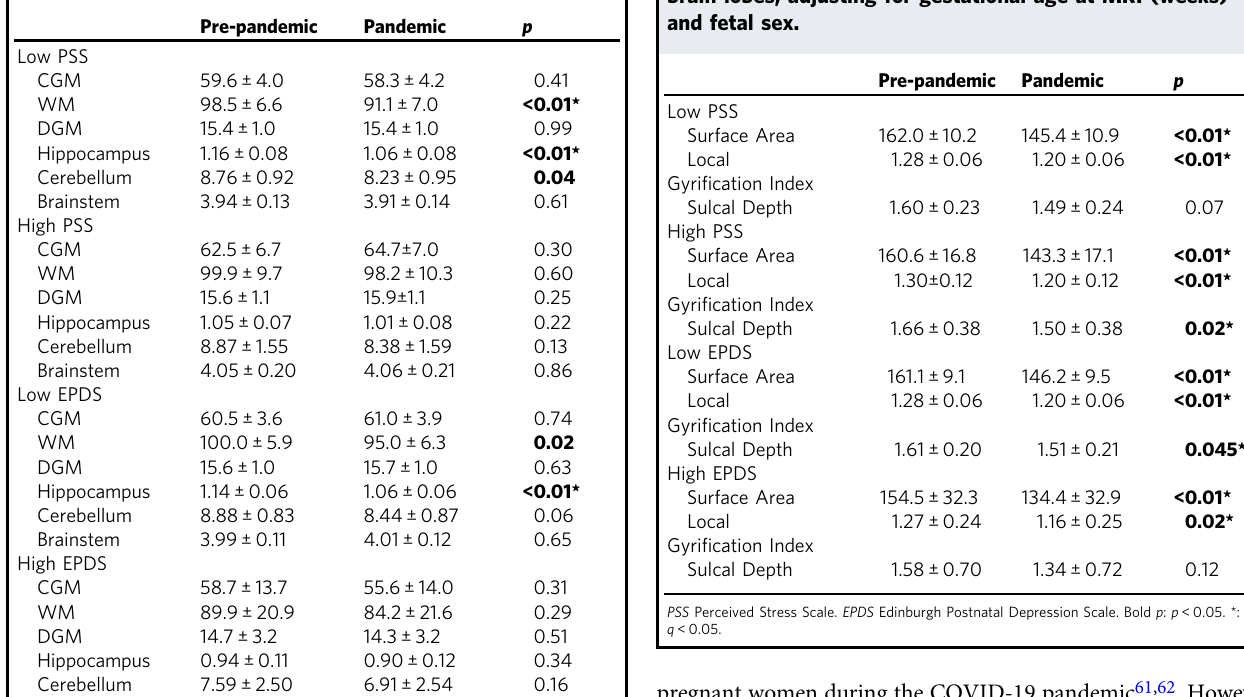
Table 3 Comparisons of brain tissue volumes (least squares mean ± standard error) between pre-pandemic and pandemic cohorts from the generalized estimating equations for the associations between fetal brain volumes (cm 3 ) and cohort status (0: pre-pandemic; 1: pandemic), adjusting for gestational age at MRI (weeks) and fetal sex.